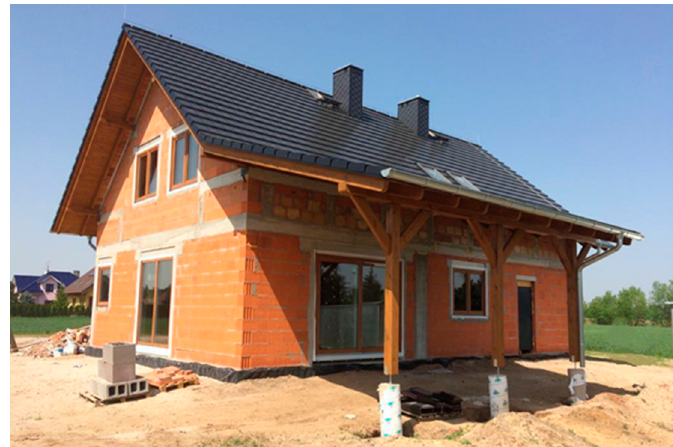
Figure 5. The analyzed building constructed with traditional materials.